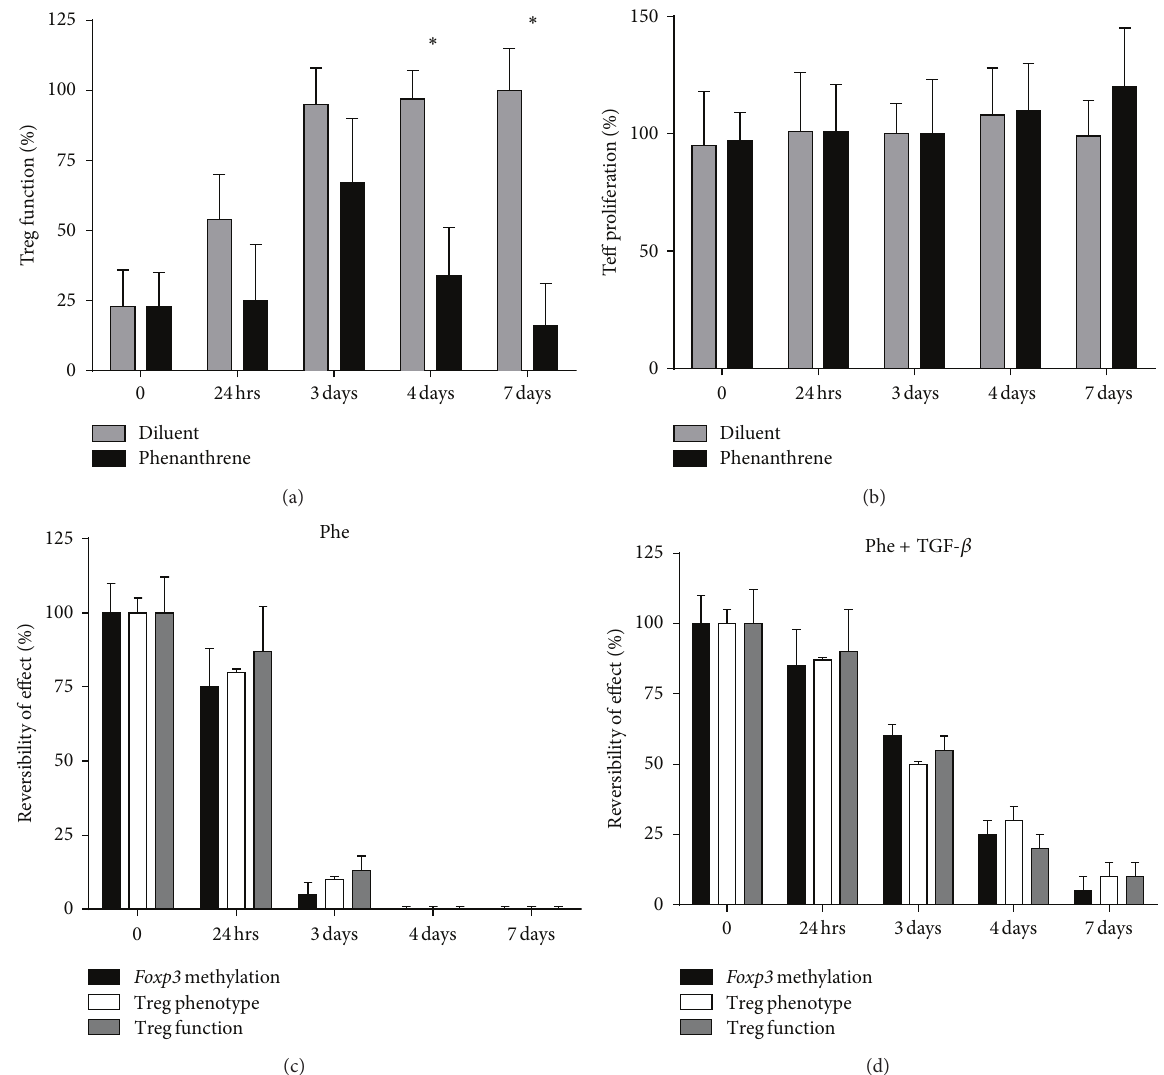
Figure 2: Phenanthrene exposure irreversibly impairs Treg function. (a) Isolated Treg from individual healthy donors ( 𝑛 = 5 ) were incubated with 300 nM Phe (black bars) or diluent (grey bars) for 0 to 7 days and analyzed for function using standard Treg suppression assays. (b) Teff proliferation was analyzed in Phe or diluent treated cultures of isolated Teff without Treg. To test the irreversibility of effects of Phe on Treg, Treg cultures were treated with Phe (c) or Phe+TGF 𝛽 (d) on day 0, followed by a wash and replacement with Phe-free media (+/ − TGF 𝛽 ) on either day 1 (24h), 3, 4, or 7. CpG methylation of the FOXP3 locus ( 𝑛 = 13 CpG sites, 6 in promoter region, 7 in intronic region) (black bars), Treg phenotype (white bars), and Treg function (grey bars) of cultured Treg were assessed on day 7. ∗ 𝑃 < 0.05 ; data represents mean +/ − SD. with improved function and maintenance of Treg